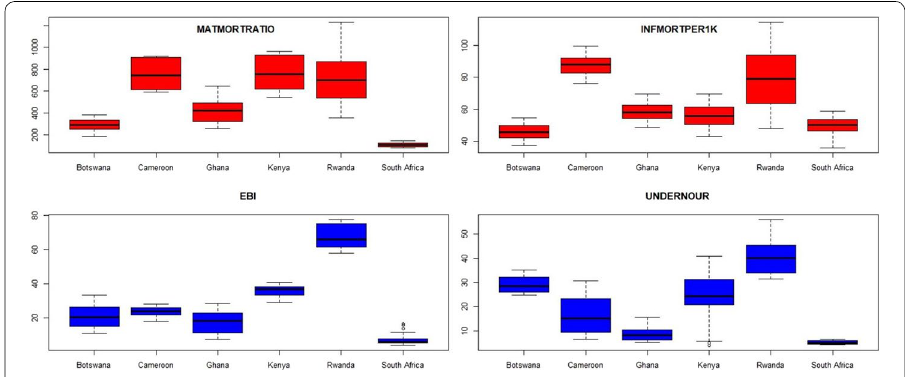
Fig. 1 Box plot distributions for four indicator variables selected from Table